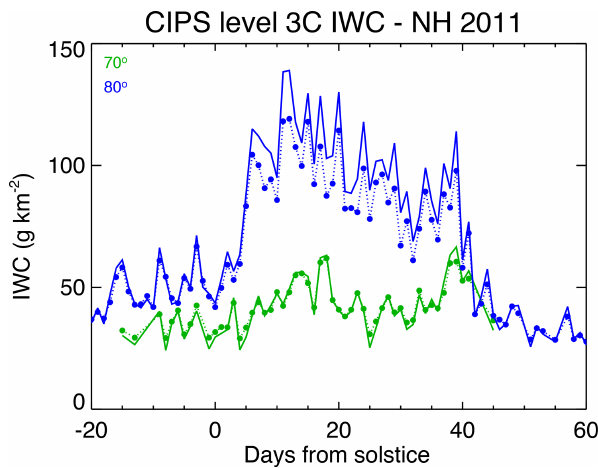
Figure 8. Filled circles and dotted line: IWC (AIR) averaged over 1 ◦ latitude bins centered on 70 ◦ (green) and 80 ◦ (blue) and over 15 orbits (from which daily averages are derived). Solid line: stan- dard L3C IWC averaged in the same